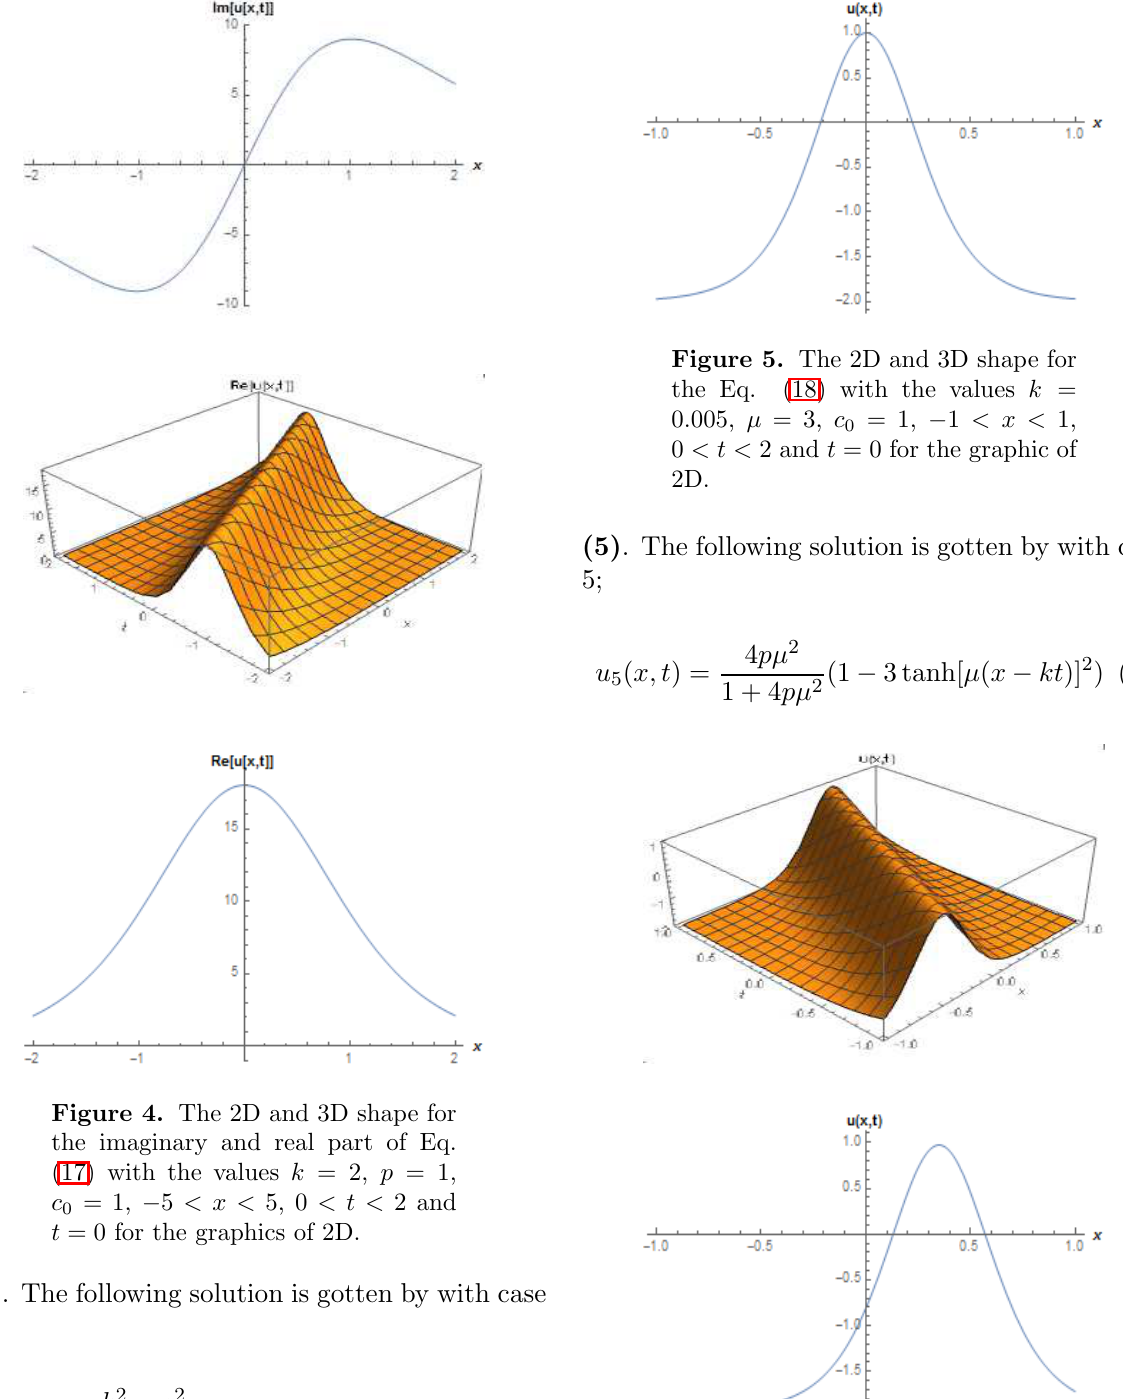
Figure 6. The 2D and 3D shape for the Eq. (19) with the values k = 0 . 5, µ = 3, p = 1, 0 . 5 < x < 1, 0 < t < 2 − and t = 0 . 7 for the graphic of